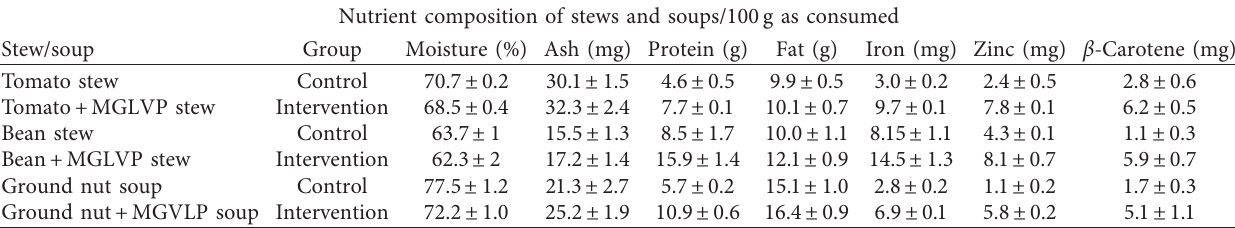
Table 3: Composition of the stews and soups consumed by study participants.